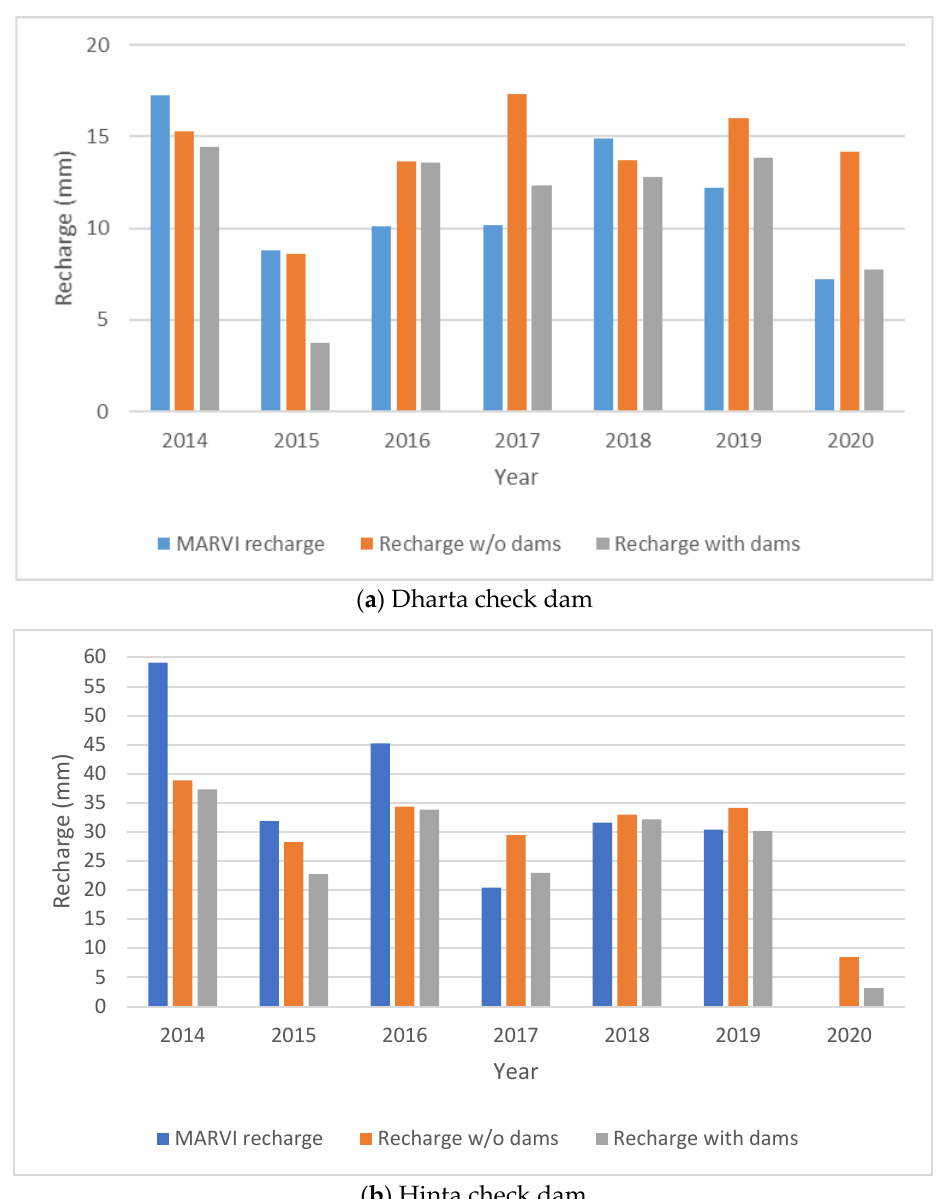
Figure 5. Recharge from ( a ) Dharta and ( b ) Hinta check dam by water balance (MARVI) and from the WaterCress model with and without upstream check dams over the whole period of 2014 – 2020.